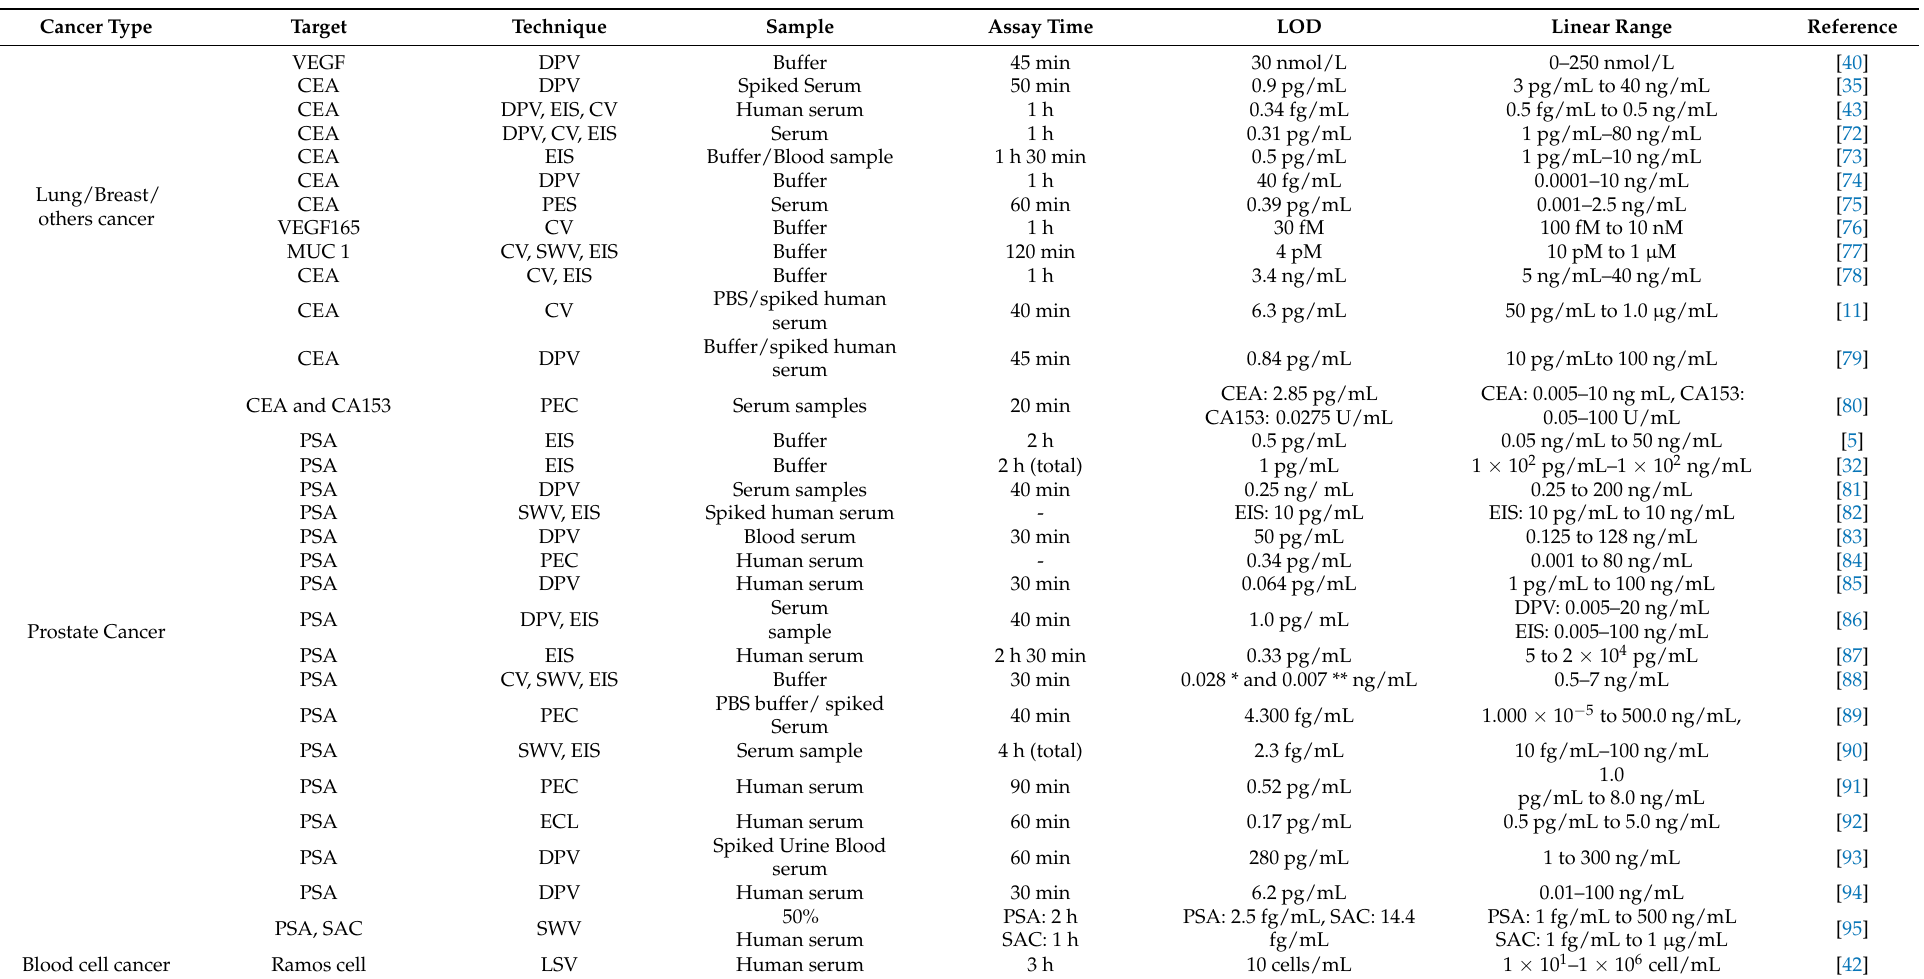
Blood cell cancer Ramos